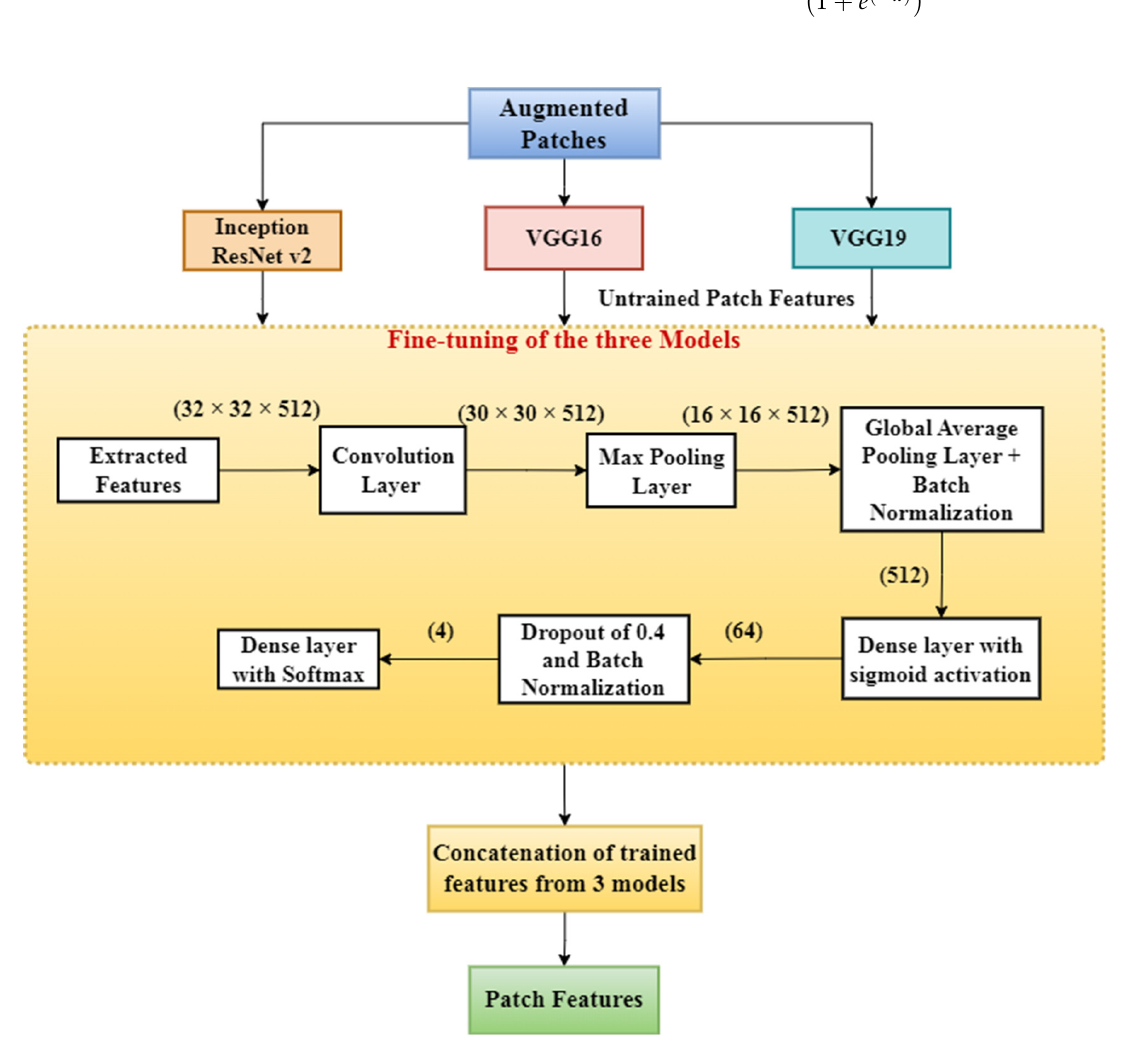
Figure 5. Feature extraction model that takes patches as the input and trains the model to provide output as a concatenated patch features set.